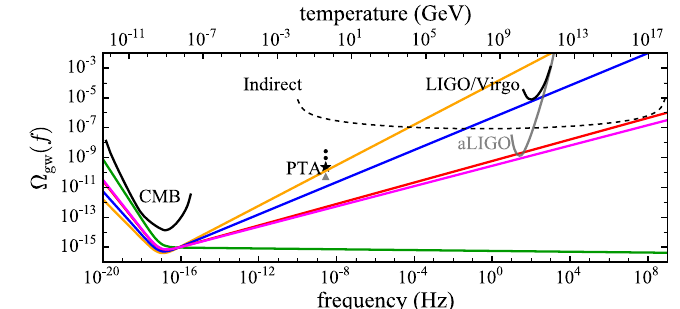
Fig. 84 Current and projected bounds on Ω gw ( f ) from CMB measurements, pulsar timing observations, and ground based interferometers. The curve marked “CMB” shows the projected sensitivity of the Planck satellite to primordial B -mode polarization anisotropies. The black star marked “PTA” is the current 95% upper limit from the Parkes pulsar timing array. The LIGO and aLIGO sensitivity curves were produced using the power-law envelope method (Thrane and Romano 2013). The curve labeled “indirect bounds” was produced by converting bounds on the total gravitational-wave energy density from CMB temperature and polarization power spectra, weak lensing, baryon acoustic oscillations, and Big Bang nucleosynthesis to bounds on the energy density per logarithmic frequency interval using power-law models. The colored lines are theoretical predictions for the primordial background assuming r = 0 . 11 and for spectral slopes n t = 0 . 68 ( orange curve ), n t = 0 . 54 ( blue ), n t = 0 . 36 ( red ), and n t = 0 . 34 ( magenta ). The prediction for the simple slow-roll inflation model discussed in this section, n t = − r / 8, is shown in green . Image reproduced with permission from Lasky et al. (2016), copyright by the